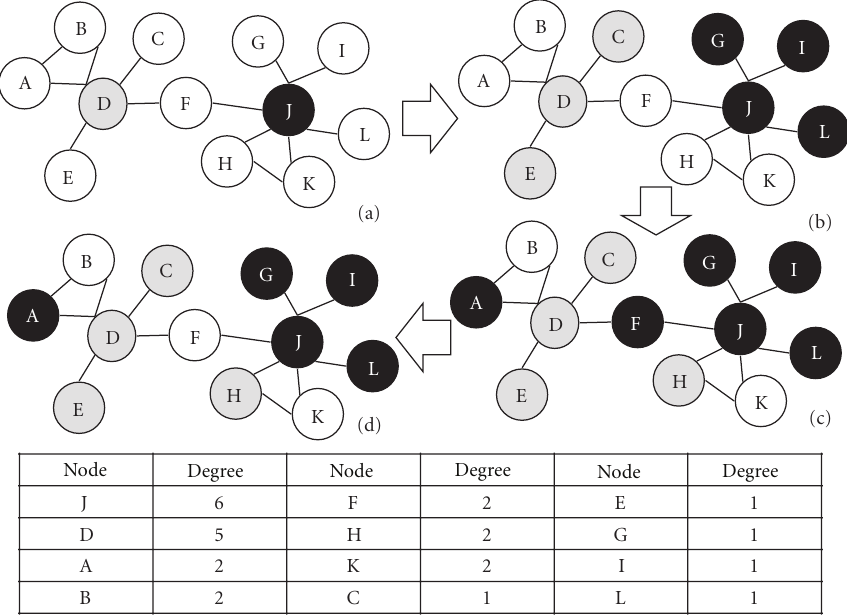
Figure 1: The steps of color-coding method. (a) Coloring the high-degree nodes in step 4. (b) The node with degree 1 having same color with its neighbor in step 7. (c) Randomly color the uncolored nodes in step 9. (d) Check the articulation hubs such as node F with di ff erent color with its neighbors in step